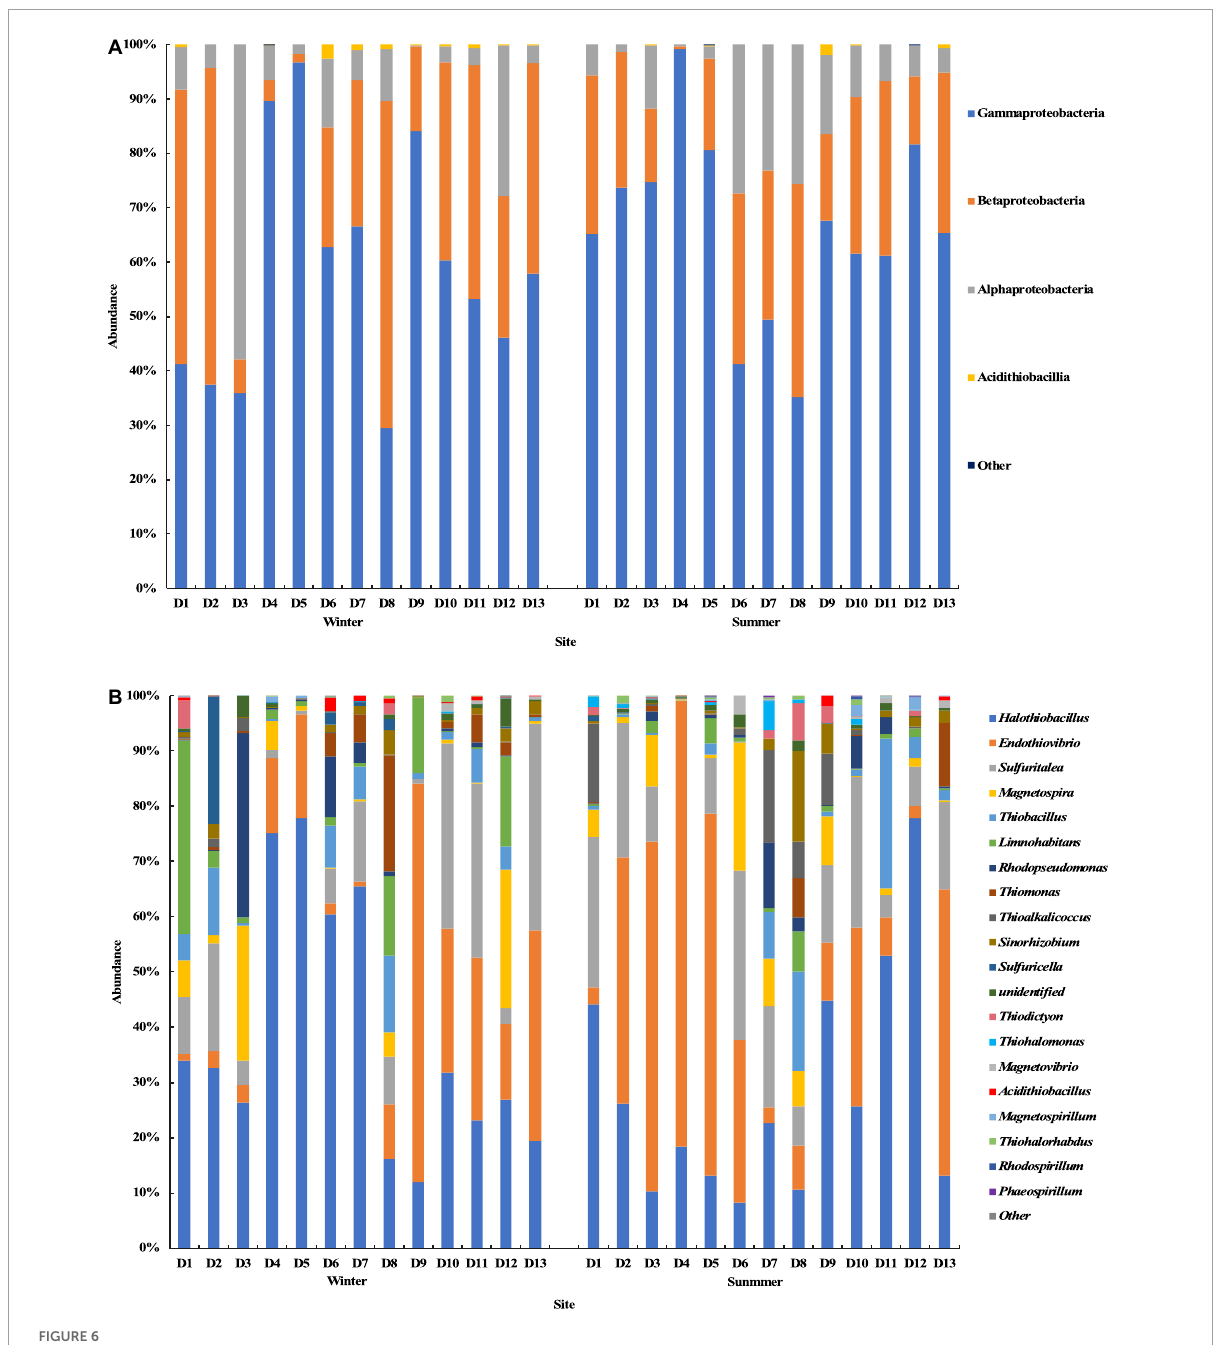
FIGURE6 Relative abundance and composition of the cbbM gene-containing CO 2 -fixing bacterial community at the class level (A) and genus level (B) in the Huixian karst groundwaters.